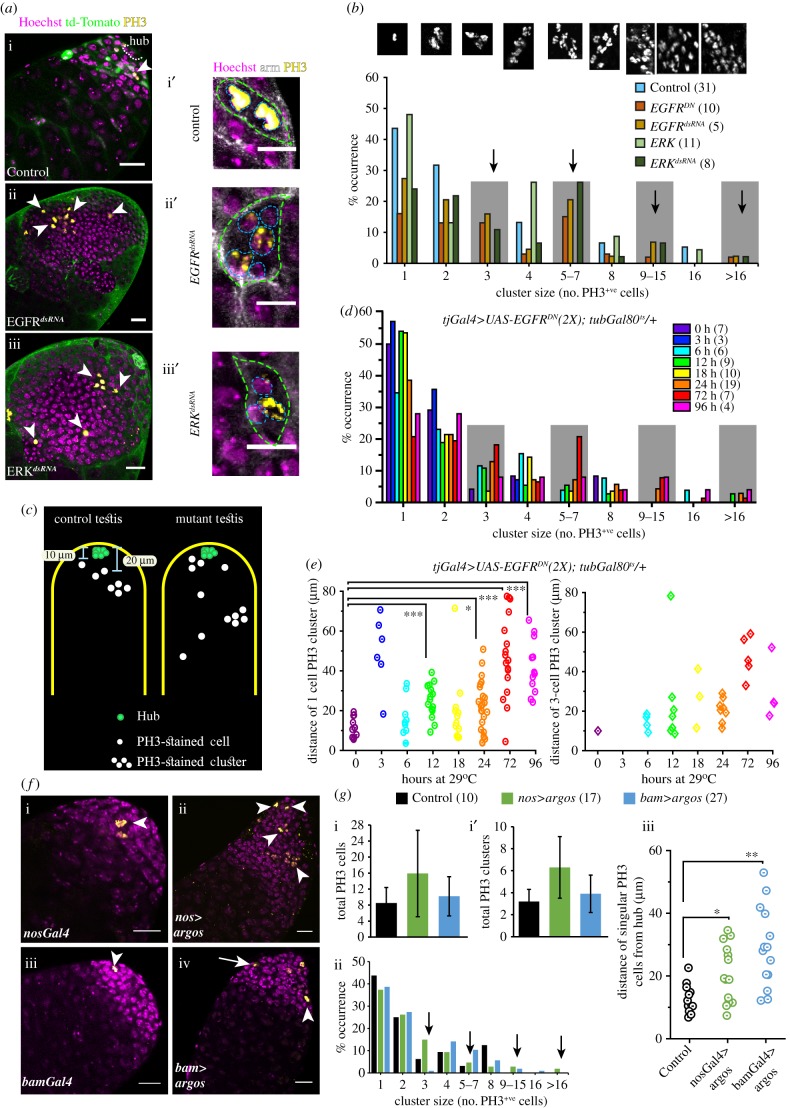
Disruption of EGFR signalling in SCCs affects the synchrony of germline divisions during TA. (a) Testes from tjGal4 UAS-tdTomato/+ (Control) (a), tjGal4 UAS-tdTomato/+; UAS-EGFRdsRNA/+(EGFRdsRNA) (b) and tjGal4 UAS-tdTomato/+; UAS-ERKdsRNA+(ERKdsRNA) (c) were stained with anti-PH3 (yellow) and the Hoechst dye (magenta). Arrowheads point to M-phase nuclei. (i′–iii′) Enlarged views of 2–4-cell cysts from the wild-type control (i′) and mutant (ii′,iii′) testes that were stained with the Hoechst dye (magenta), anti-Arm (white) and anti-PH3 (yellow). Cyst boundaries (dashed green) and germ cells (dashed cyan) are marked. (b) Histograms depict relative, size-wise distribution of PH3-stained clusters in different genetic backgrounds. Shaded boxes and arrows highlight odd-sized clusters. (c) A schematic depicts the typical distribution of PH3-stained cells and clusters along the length of the testis. The control represents a summary of observation from tjGal4/UAS-His-RFP, and the mutant summarizes the observations made in the EGFRDN backgrounds as shown in panel (e). (d) Histograms depict relative distributions of odd and even-sized PH3-stained clusters with decreasing dose of EGFR activity in SCC. (e) Cluster plots depict distance of 1- and 3-cell PH3-stained clusters from the apical tips of testes. (f) Testes from nosGal4vp16 (i), UAS-argos/+; nosGal4vp16/+(nos>argos) (ii), bamGal4vp16 (iii), and bamGal4vp16/UAS-argos (bam>argos) (iv), were stained for PH3 (yellow) and with the Hoechst dye (magenta). (g) Histograms depict mean (±s.d.) (i,i′) and relative, size-wise, distributions (ii) of PH3-stained clusters obtained from the control (nosGal4vp16) and two different mutant backgrounds. (iii) Scatter plots depict distances of singular PH3-stained cells from the testis apex in different backgrounds. All scale bars, error bars and statistical significance values are applied according to the description in figure 1. Scale bars for a-i′, a-ii′ and a-iii′ measure 10 µm.